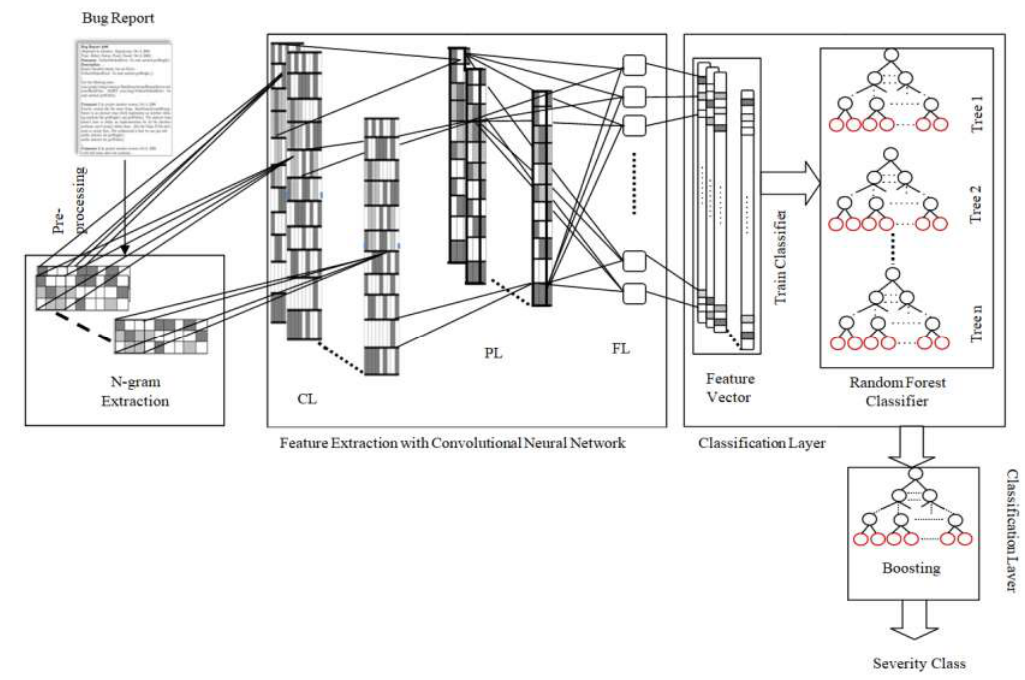
Figure 3. Bug Severity classification using a Convolutional Neural Network and Random forest with Boosting (BCR) model: an n-gram as the n-gram feature extractor, CNN as the feature extractor, and random forest with boosting as the classifier .